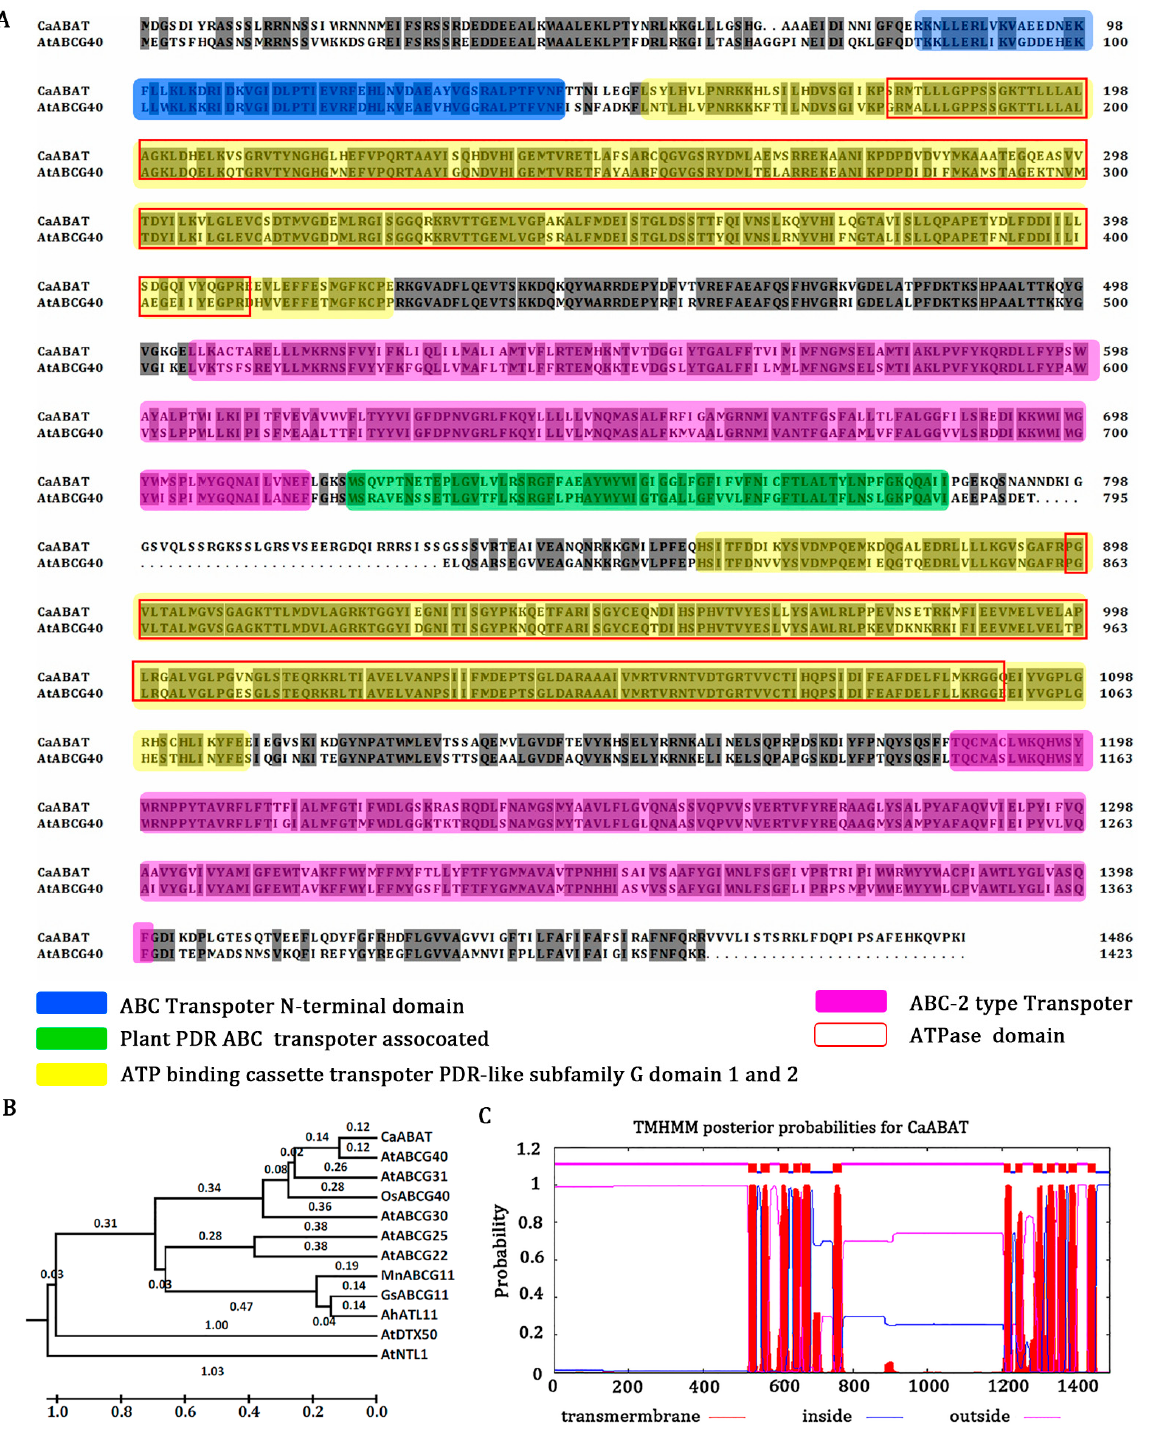
Figure 1. CaABAT is a member of the ABC transporter family. ( A ) Alignment of amino acid sequences of CaABAT with AtABCG40. ABC transporter domain (CaABAT 81–143 aa), ATP binding cassette transporter PDR-like subfamily G domain 1 (CaABAT 152–425 aa) and domain 2 (857–1112 aa), ABC-2 type transporter (504–716 aa, 1185–1399 aa), ABC transporter associated (CaABAT 721–784 aa), ATPase domain (CaABAT 177–409 aa, 897–1089 aa). ( B ) Phylogenetic relationships of CaABAT with other ABA transporters by MEGA6. AtABCG31: Q7PC88.1; AtABCG30: Q8GZ52.2; GsABCG11: KHN26506; MnABCG11: XP_010094142; AtABCG11: Q8RXN0.1; AtABCG40: Q9M9E1.1; AtABCG25: Q84TH5.1; AtNTL1: Q8H157.1; AtDTX50: Q9FJ87.1; AtABCG22: Q93YS4.1; AhATL11: